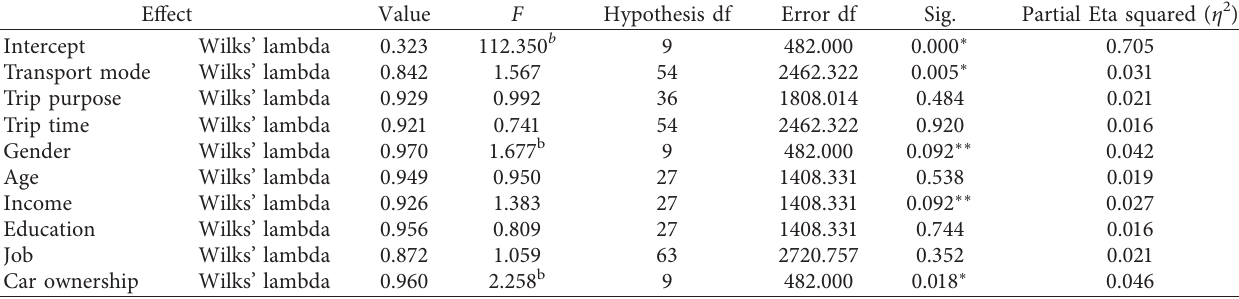
Table 7: Onboard activities across variables (i.e., groups): the results of the multivariate analysis test a .